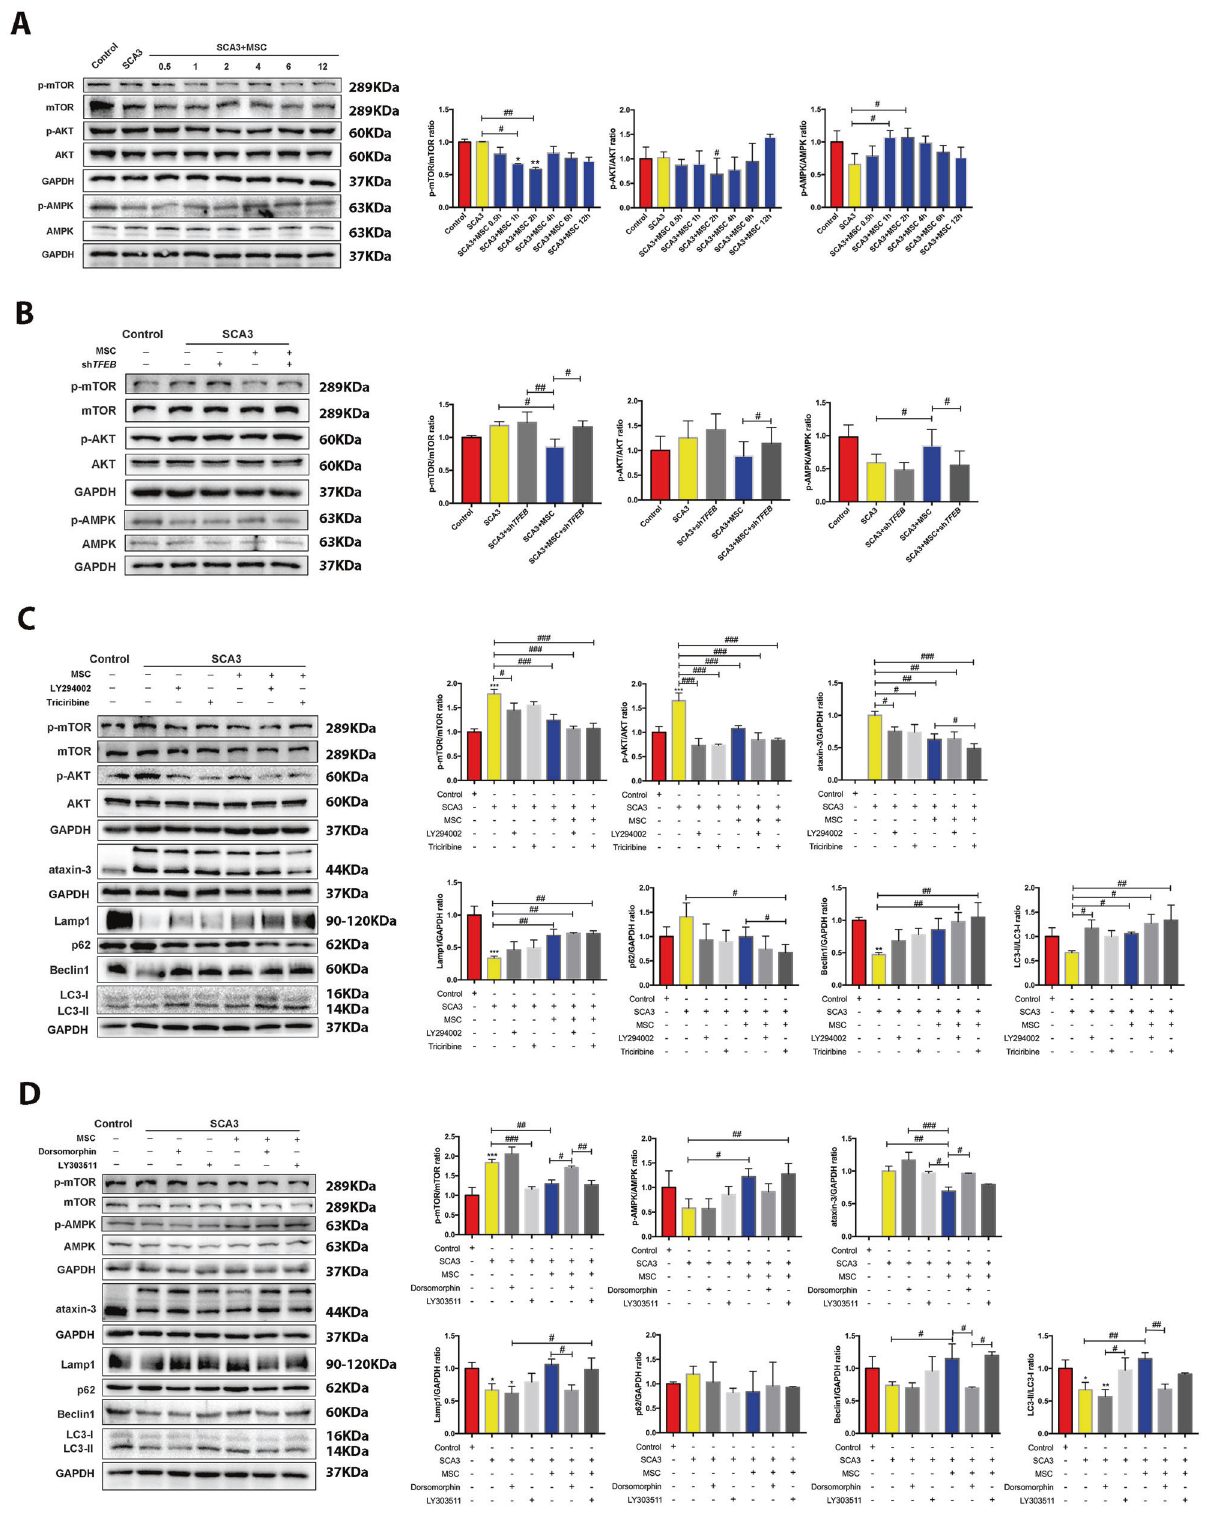
Fig. 5 MSCs activated autophagy by regulating the AKT/mTOR and AMPK/mTOR signaling pathways to reduce the intracellular mutant protein ataxin-3. A The expression levels of p-AKT, p-mTOR, and p-AMPK at various times after MSCs therapy. B The effects of shTFEB on the expression of p-AKT, p-mTOR, and p-AMPK after MSCs. C The effect of LY294002 and triciribine on the expression of levels of p-AKT, p-mTOR, ataxin-3, and autophagy-related proteins after MSCs therapy. D The effect of LY303511 and dorsomorphin on the expression of levels of p- AKT, p-mTOR, ataxin-3, and autophagy-related proteins after MSCs therapy. * p < 0.05, ** p < 0.01, *** p < 0.001 vs Control group, # p < 0.05, ## p < 0.01, ### p < 0.001.